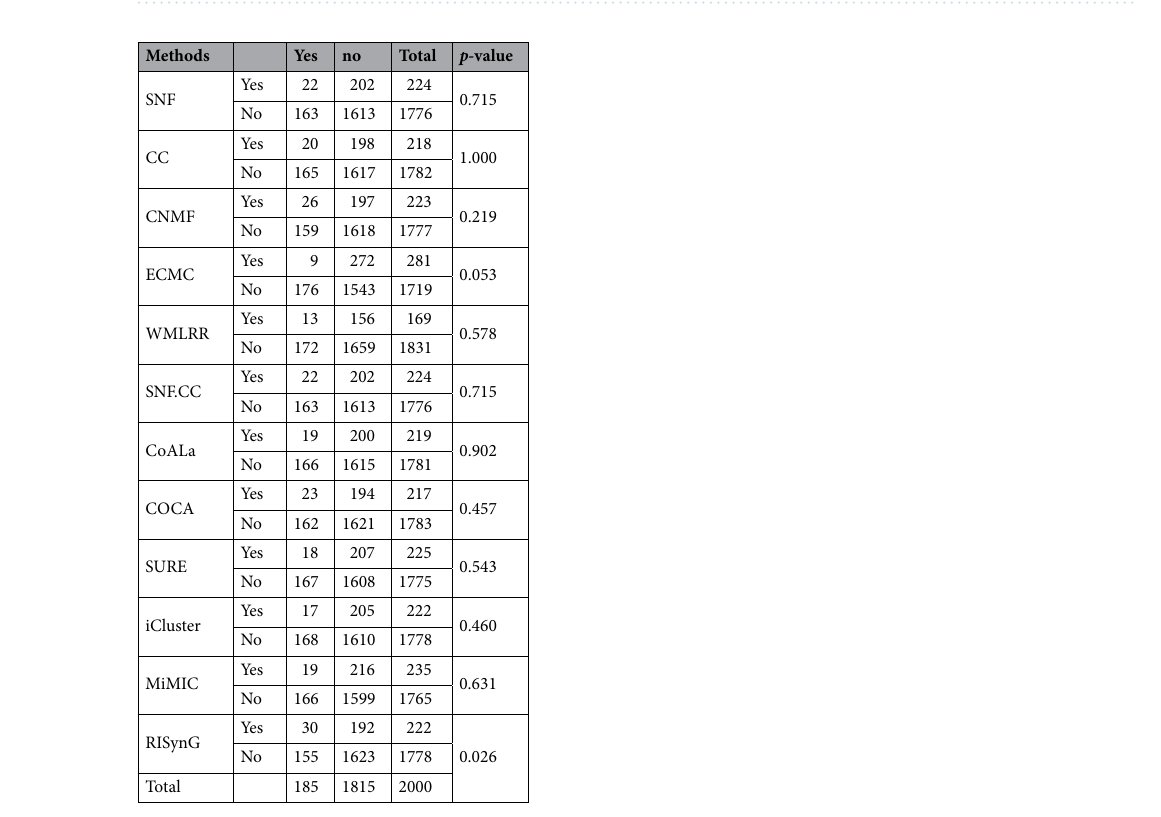
Table 9. Comparative biological analysis of STAD dataset. The bold values indicate the best score as reported in the text.